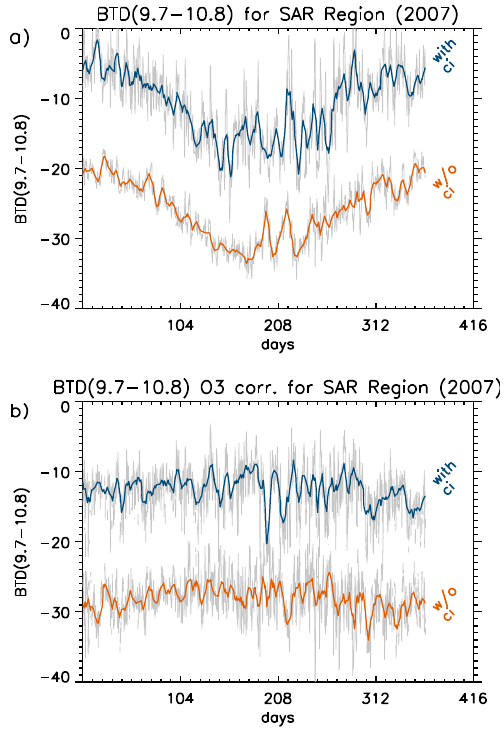
Fig. 5. (a) Daily mean of T 9 . 7 − T 10 . 8 for MeCiDA Tests 1–5 cir- rus clouds (blue) and cirrus free pixels (red) averaged over the SAR region as a function of day of the year in 2007. (b) Daily mean of T 9 . 7 − T 10 . 8 after correction of the ozone annual cycle for MeCiDA Tests 1–5 cirrus clouds (blue) and cirrus free pixels (red) averaged over the SAR region as a function of day of the year in 2007. Grey curves represent the same BTDs but with the full temporal resolu- tion of